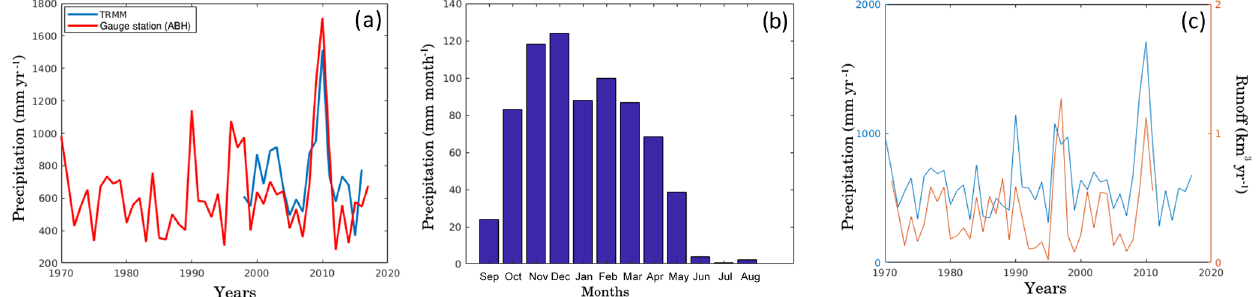
Figure 7. The hydrology of the Oued Laou watershed. (a) Interannual variability of precipitation and comparison with TRMM. (b) Monthly variability of precipitation. (c) Annual precipitation vs. annual runoff.